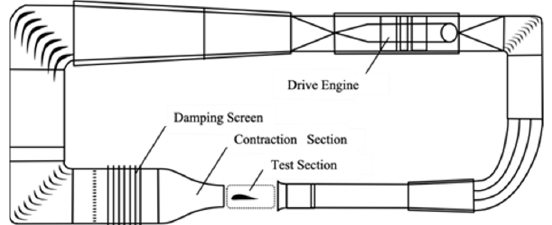
Figure 4. Schematic diagram of return flow low ‐ speed wind tunnel.